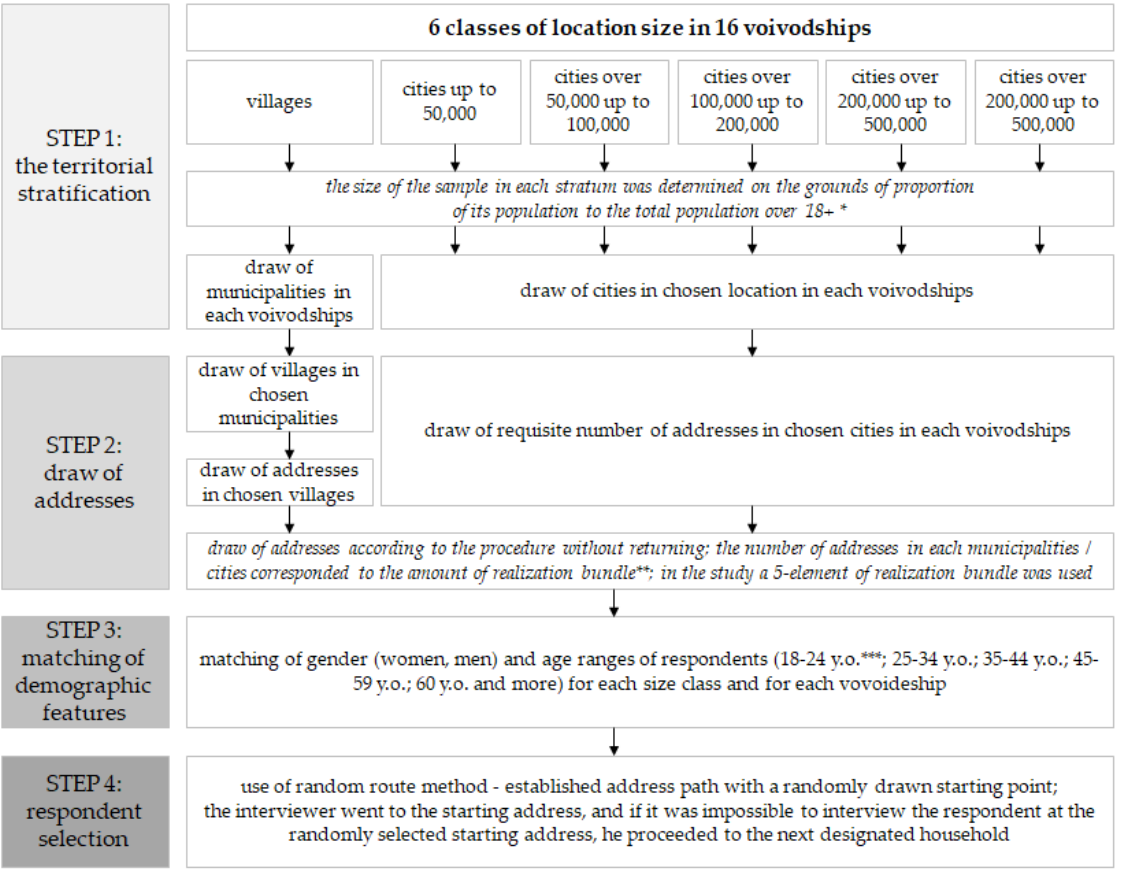
Figure 2. The phases of the sample selection procedure. * demographic data being the basis of territorial stratification come from the Central Statistical Office [63]; ** realization bundle—includes a group of spatially clustered addresses—most often selected in one town [64]; *** y.o.—years old.